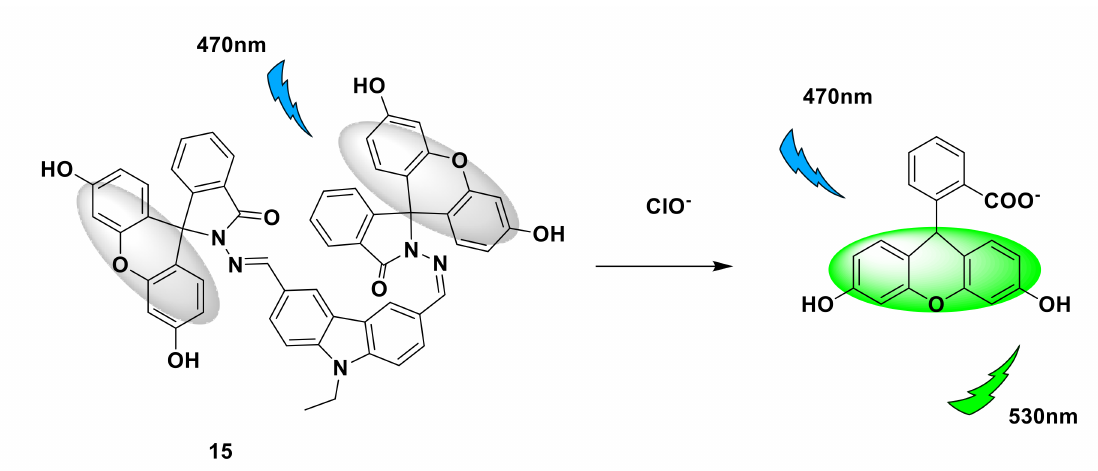
Figure 17. The reaction of probe 15 and ClO − .